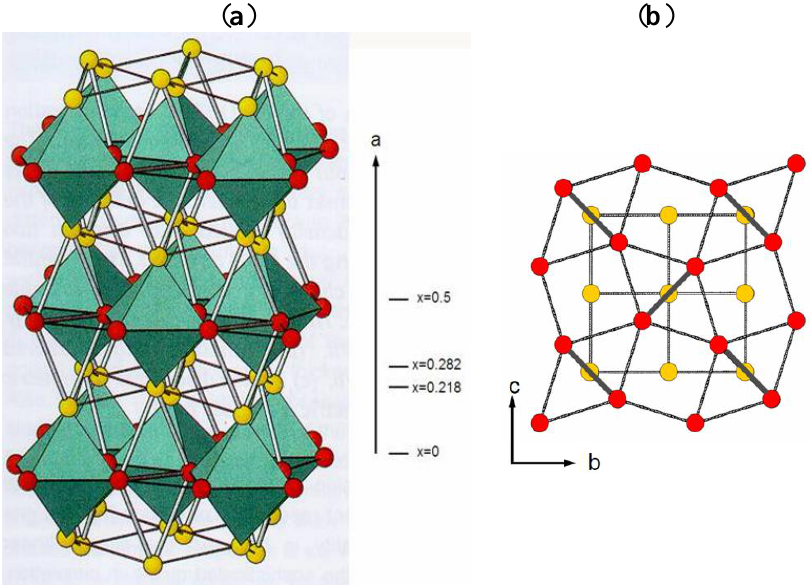
Figure 1. Crystal structure oC 16- Cmca of Si-VI. ( a ) A perspective view. The atomic positions 8f and 8d are denoted as red and yellow, respectively; ( b ) A projection along the a -axis for nets at x = 0.5 (red) and x = 0.218 and 0.282 (yellow). The structure can be viewed as an alternating sequence of planar layers formed by square-triangle nets and puckered nearly square layers. The shortest interatomic distances are marked by dark lines (modified from [4]).